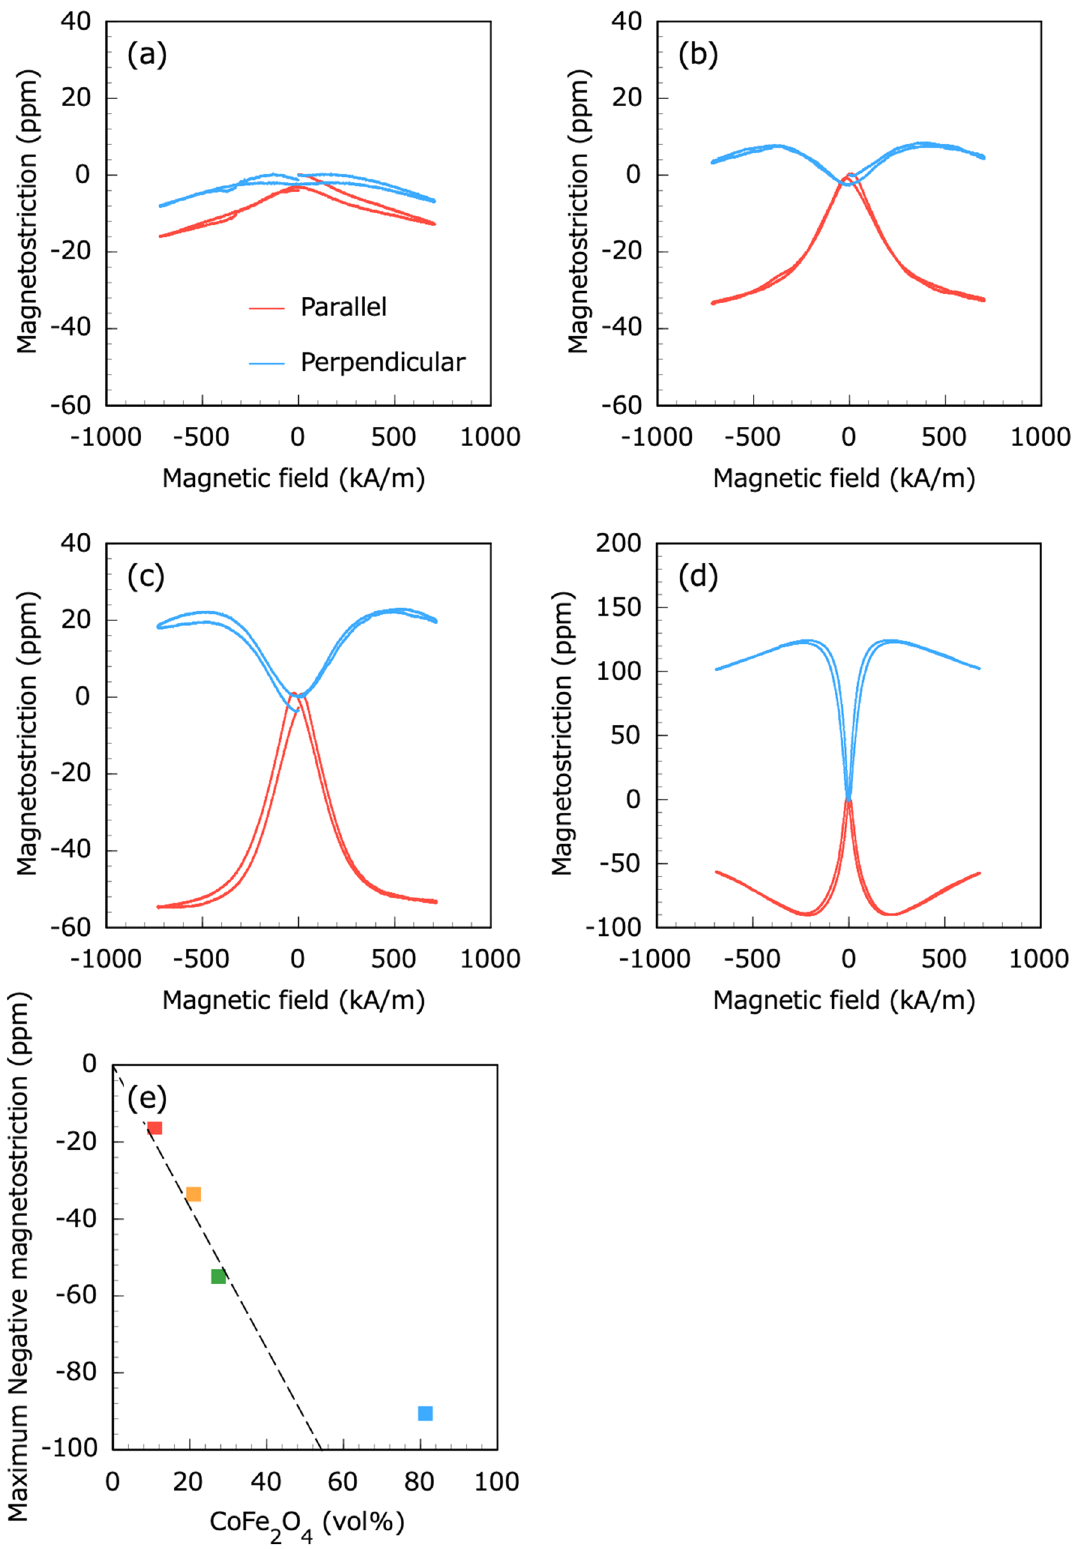
Figure 7. Magnetostrictive properties of the CNF–CoFe 2 O 4 composite papers with CoFe 2 O 4 contents of ( a ) 10.9, ( b ) 21.0 and ( c ) 27.5 vol% and ( d ) the CoFe 2 O 4 plate; ( e ) plot of maximum negative magnetostriction versus CoFe 2 O 4 volume